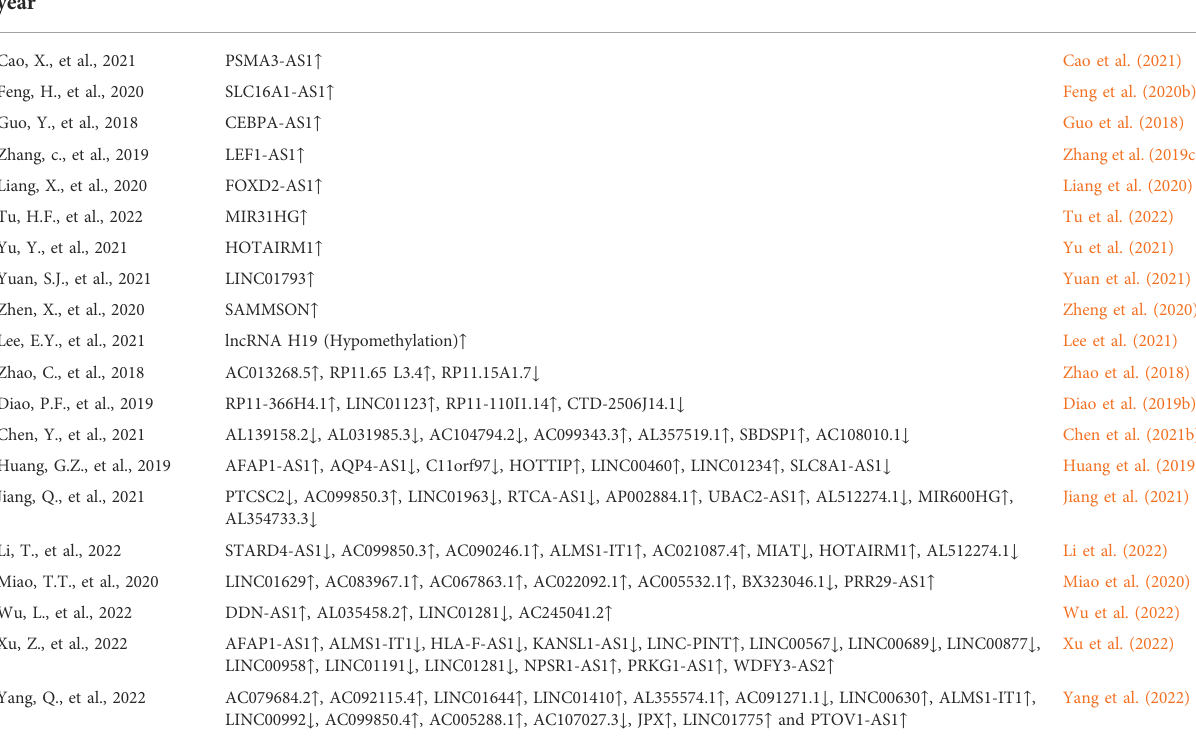
TABLE 3 LncRNAs in fl uence OSCC patient prognostic